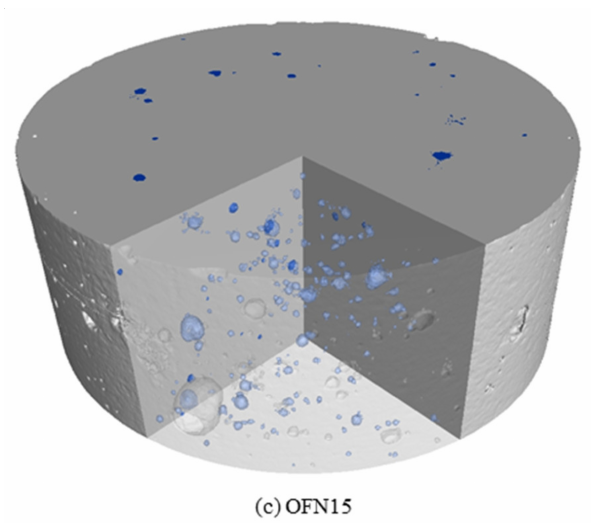
Figure 8. X-ray tomography of concrete; ( a ) OPC, ( b ) OFN0, ( c )